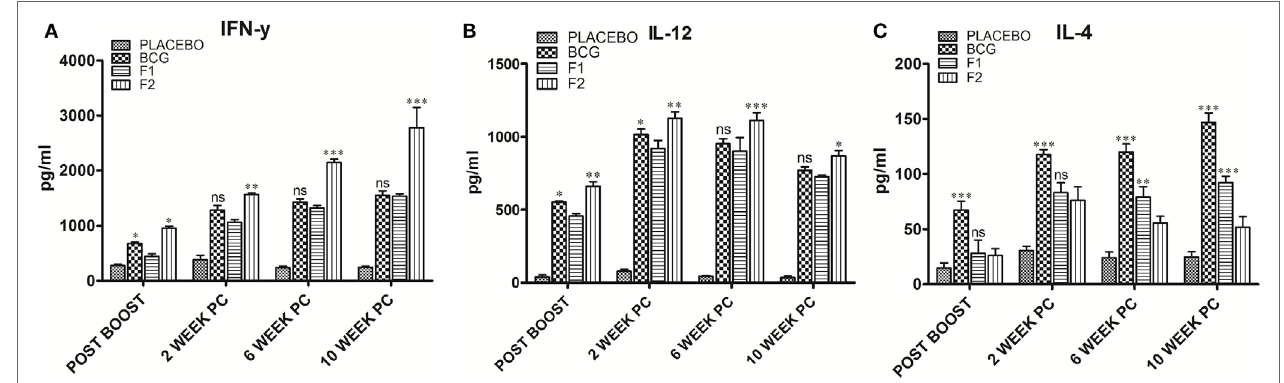
FigUre 4 | Ag85B aggregate mediated upregulation of Th1 cytokines in the immunized animals. Assessment of Ag85B aggregate-mediated Th1/Th2 bias, as ascertained by determining cytokine response (employing sandwich ELISA) in different immunized groups at various time points; (a) IFN- γ , (B) IL-12, and (c) IL-4. To induce ex vivo cytokine expression, splenocytes from groups of animals immunized either with Rv1886-IFA (F1) or aggregated Ag85B (F2) were stimulated with corresponding set of matching antigens (5 µg/ml). Lymphocytes isolated from Bacillus Calmette–Guerin (BCG) group were stimulated with BCG whole cell antigen (10 µg/ml) while cells from placebo immunized group were primed with whole cell antigen of Mtb H 37 Rv (10 µg/ml). The data were analyzed by employing Two-way ANOVA following by Bonferroni’s multiple comparison test and are shown as the means ( ± SD) of three independent determinants where; p < 0.05(*), p < 0.01(**), and p < 0.001(***) were considered